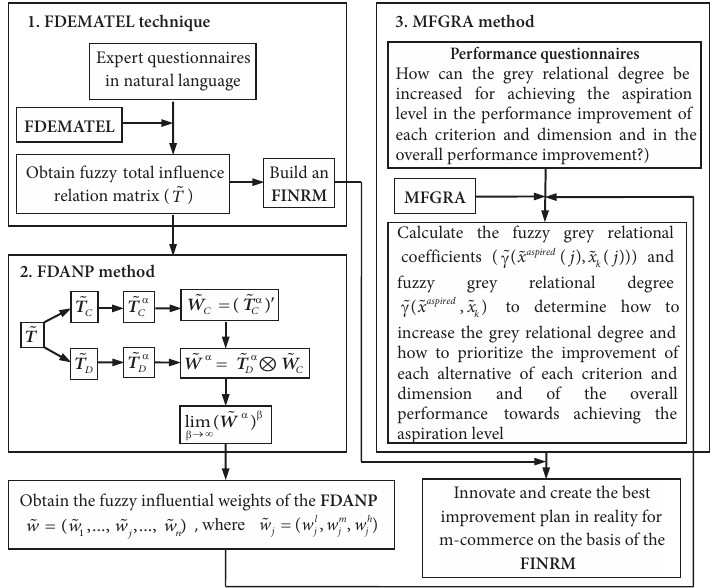
Figure 2. Hybrid FMADM model